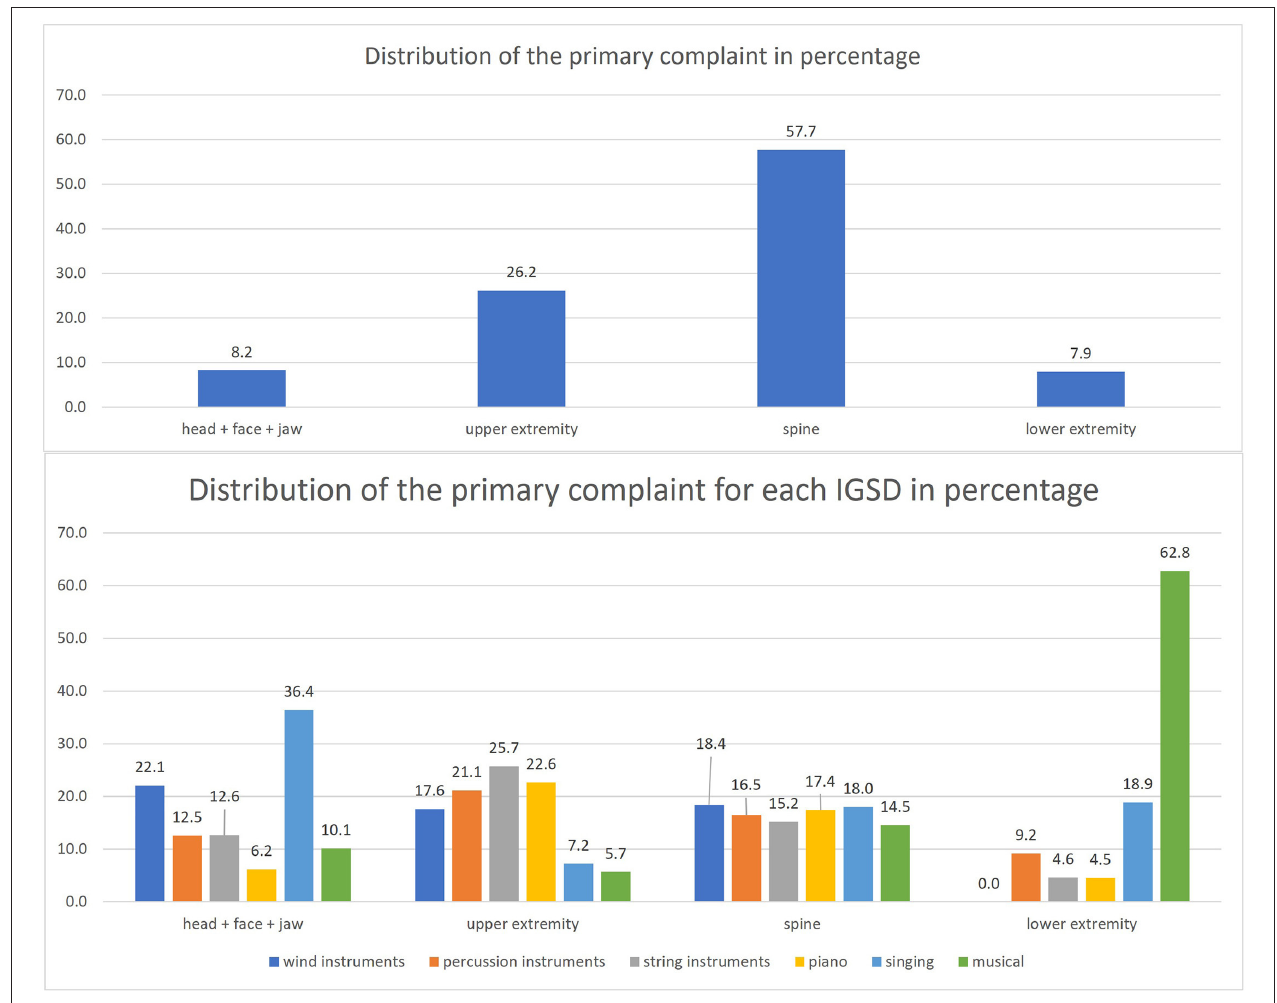
FIGURE 1 | Distribution of the primary